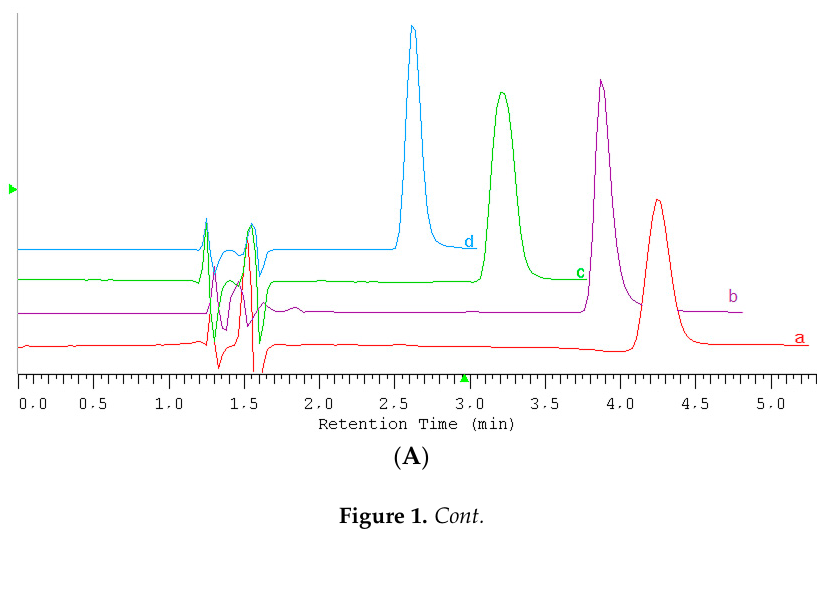
Table 2. The mobile phase components suitable for HPLC analysis of appropriate ionic liquids on a Zorbax Extend-C18 column.